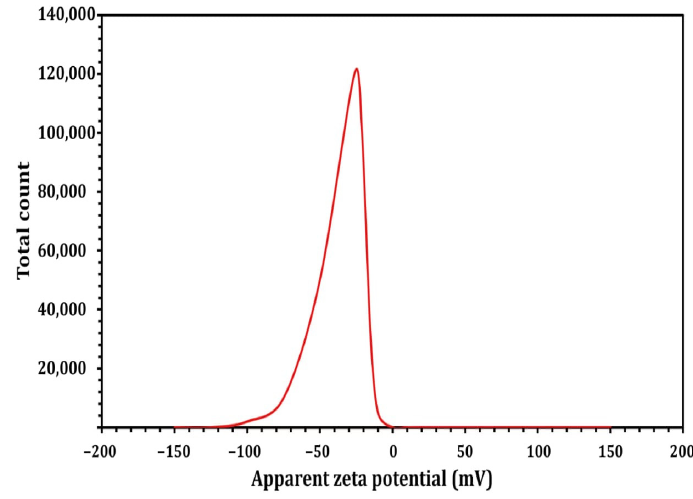
Figure 7. Zeta potential result of the Streptomyces rochei MS- 37 SNPs.